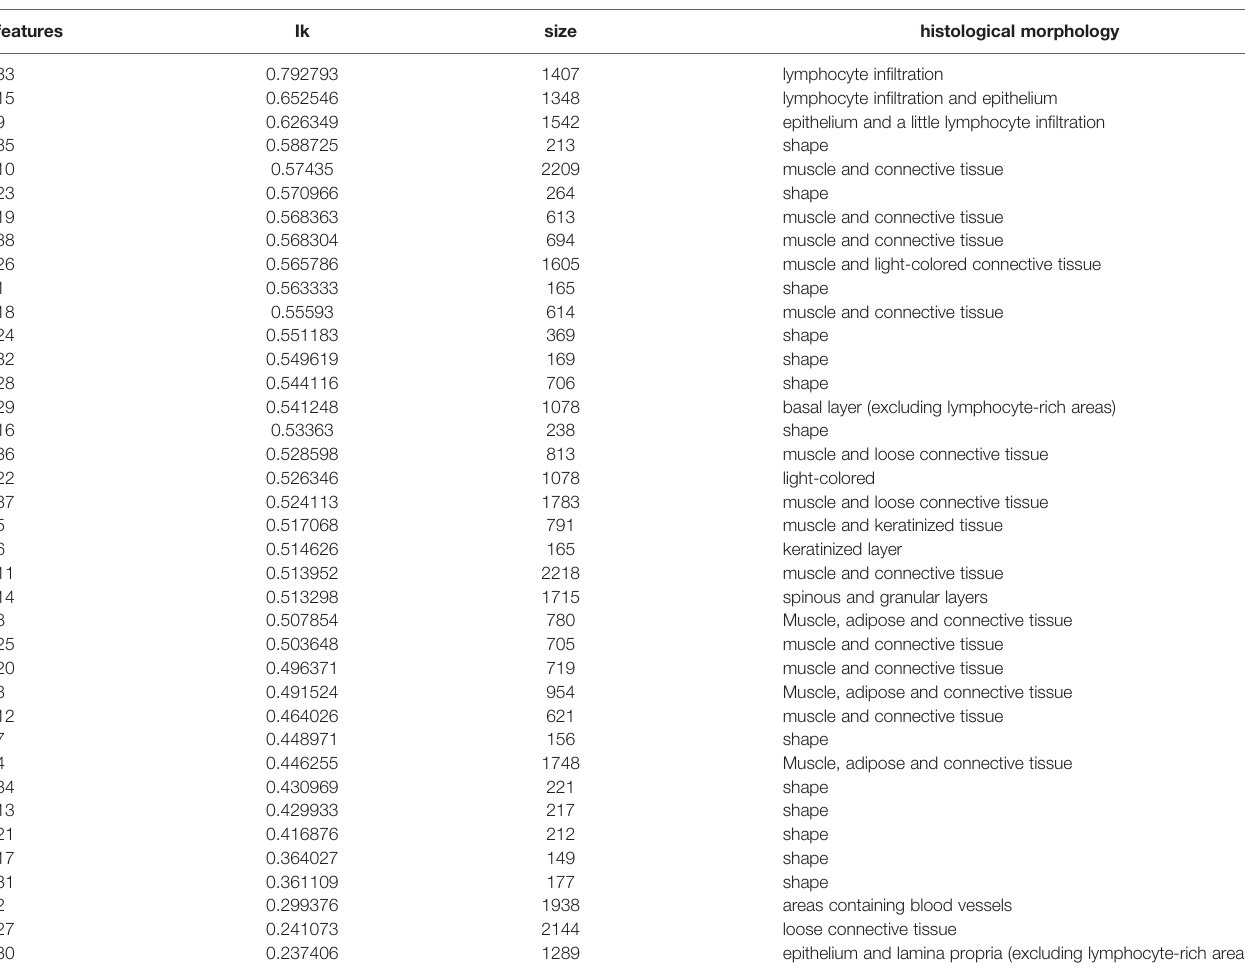
TABLE 2 | 38 features and their patch numbers, histological morphology. features